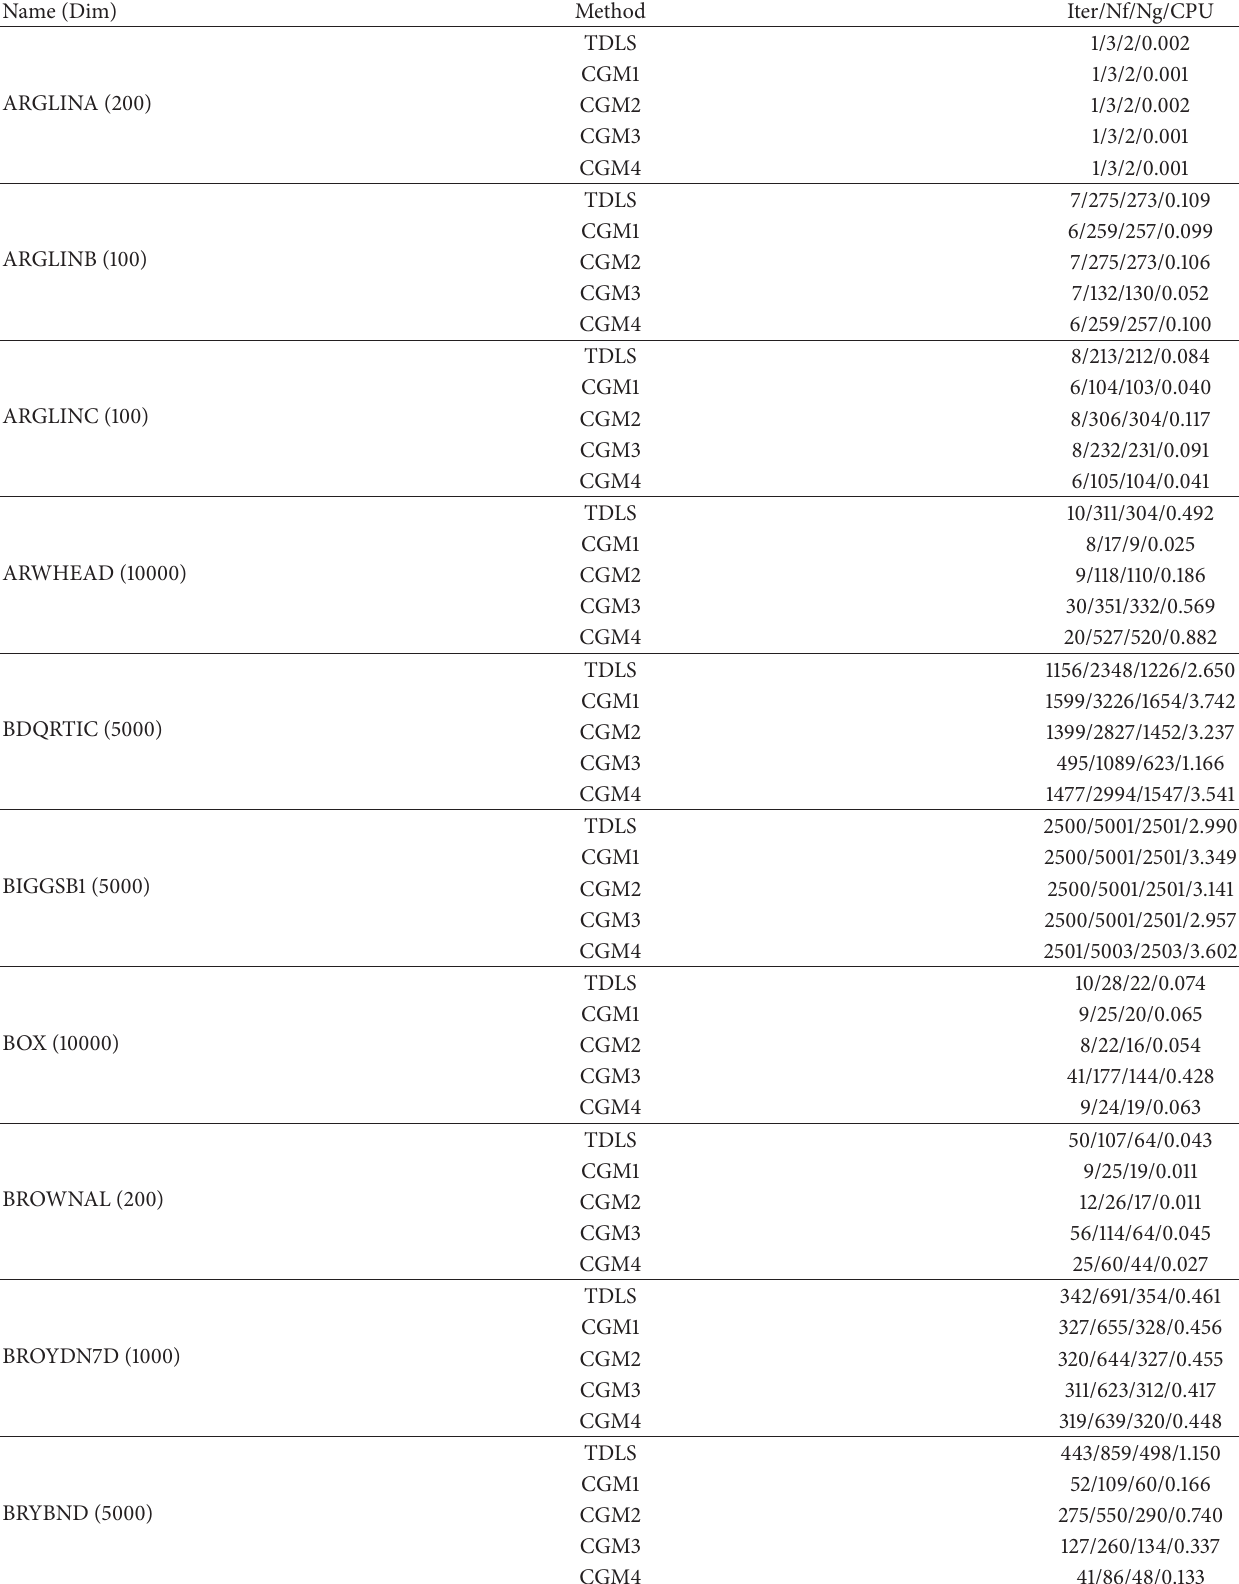
Table 1: Numerical results for test problems from the CUTEr